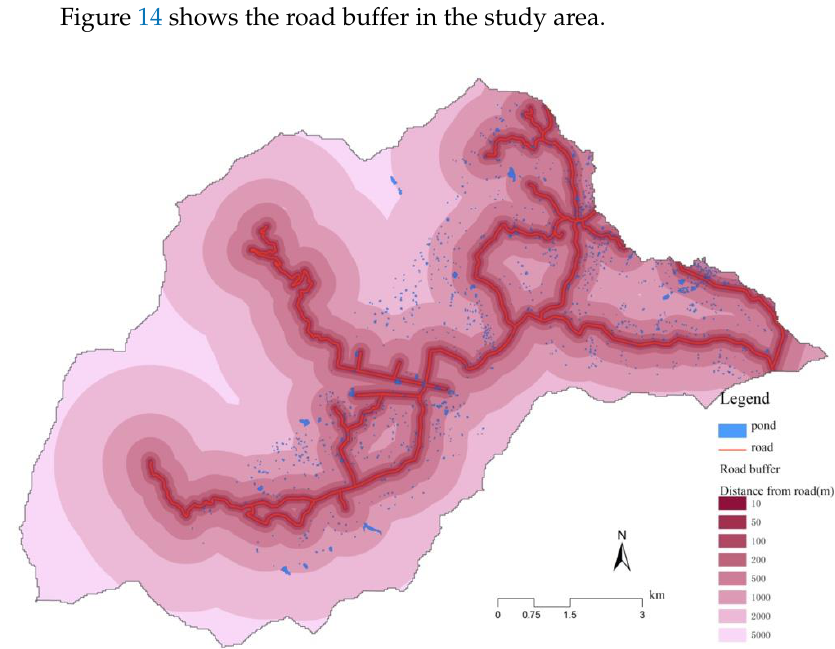
Figure 14. The road buffer result.